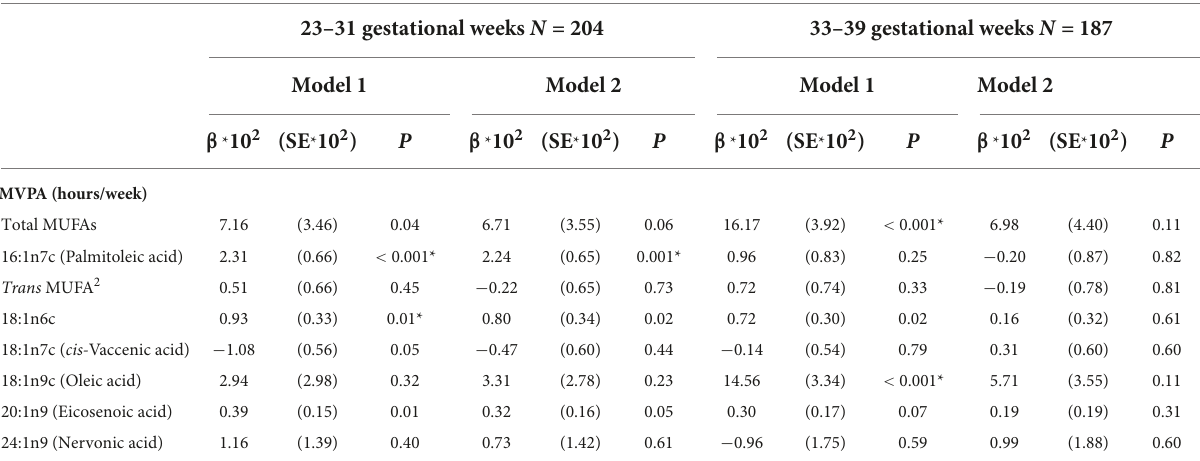
1 Model 1: unadjusted models. Model 2: multivariable models adjusted for age (years), race, education, marriage status, nulliparous, pre-pregnancy BMI (kg/m 2 ), AHEI score, and sedentary behavior (hour/week). AHEI score used mean imputation for missing values. Analytical sample size for each time point was 318, 308, 204, and 187 at 10–14 GWs, 15–26 GWs, 23–31 GWs, and 33–39 GWs, respectively. Sampling weights were applied to all analyses to represent the full NICHD Fetal Growth Studies-Singletons population. * P -value is significant after Bonferroni correction. Previous year’s habitual PA was measured at baseline and PA since the last visit was measured in following visits. Individual MUFA was